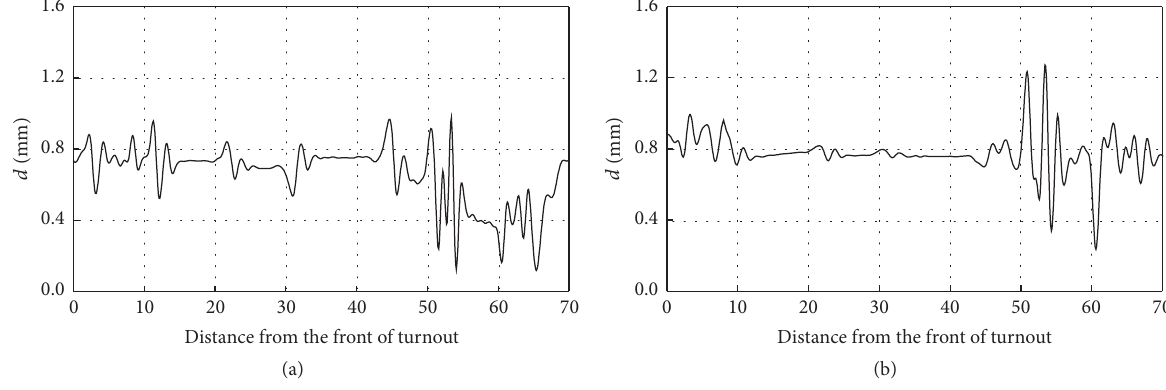
Figure 11: Vertical rail displacement ((a) original track stiffness; (b) optimised track